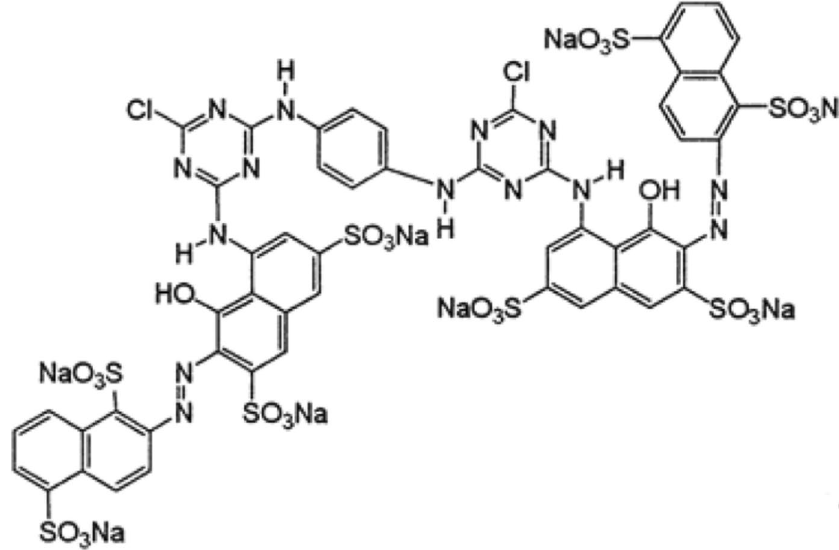
Fig. 1 Structural formula of